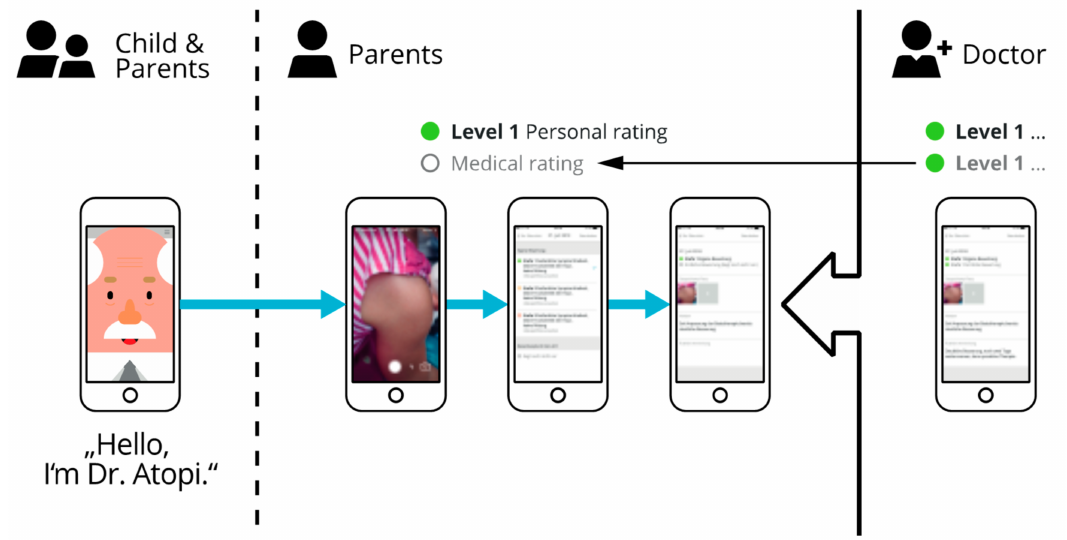
Figure A4. Severity rating in atopi app. Parents take a picture of current skin condition and make a rating (for example Stage 1) and receive feedback by a physician, who makes their own rating according to the provided photograph of skin